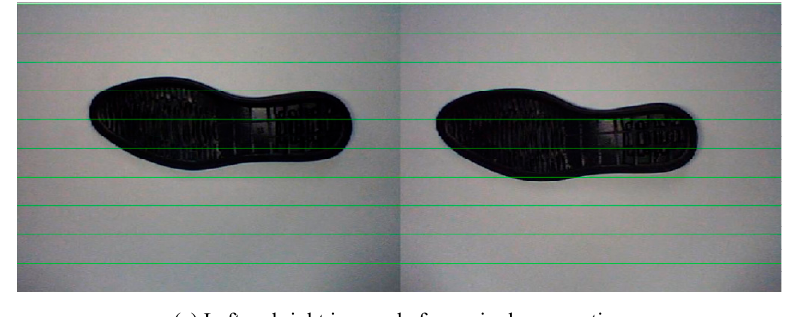
Figure 11. Leather sole images before and after polar line correction.